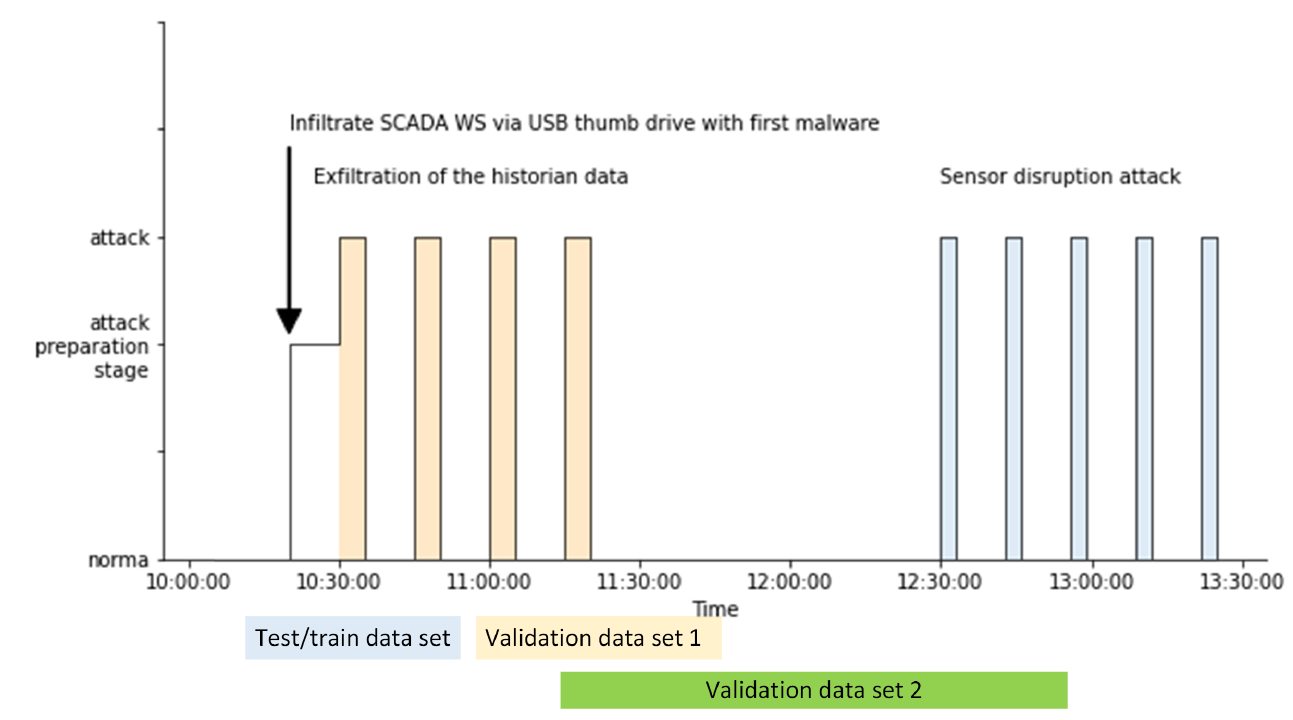
Figure 4. Timeline of the attacks in the SWaT dataset.